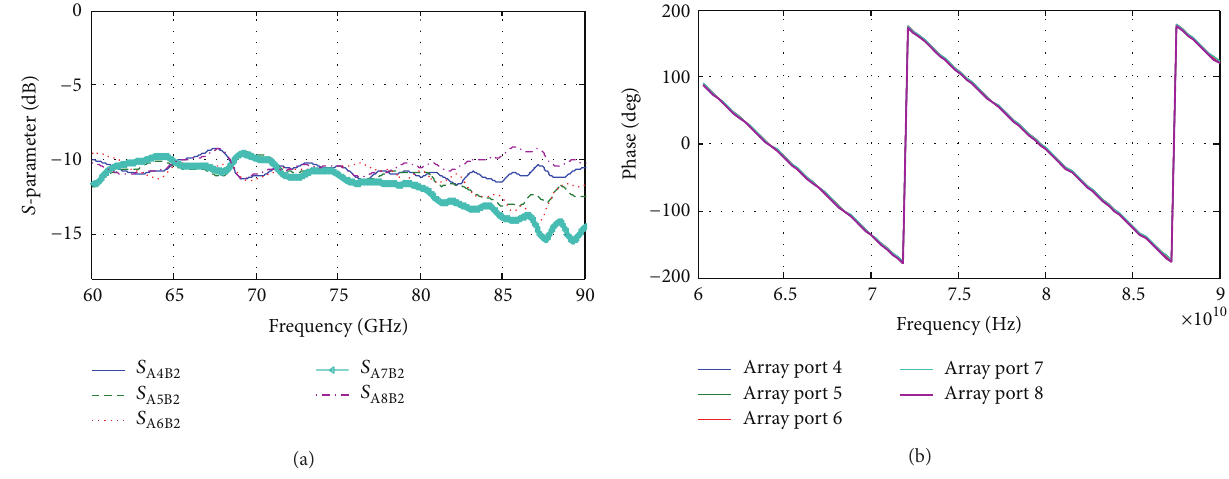
Figure 8: 𝑆 -parameter for beam port number two active, (a) magnitude, (b)